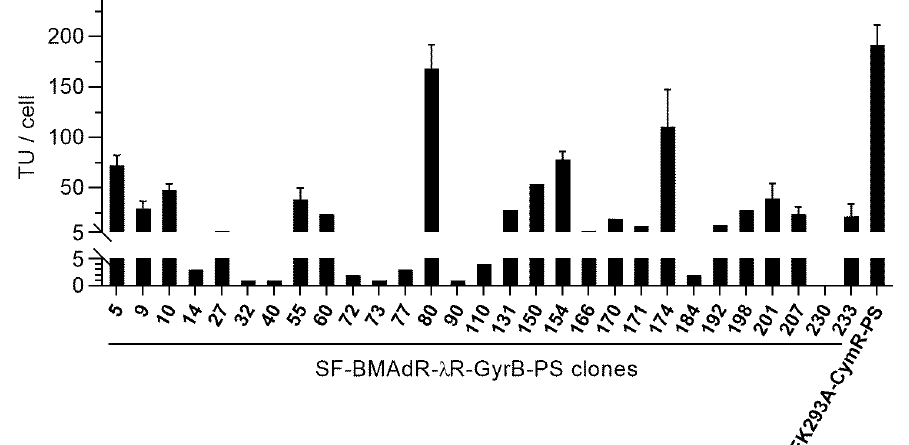
Figure 2. Comparative production of AdPS-/CU by SF-BMAdR- λ R-GyrB-PS clones. Cells were infected with AdPS-/CU using a MOI of 5 transduction unit(s) (TU)/cell in the presence of coumermycin (5 nM) for SF-BMAdR- λ R-GyrB-PS clones and cumate (50 µ g/mL) for HEK293A- CymR-PS pool. The specific productivities of infectious vector particles (TU/cell) were determined by flow cytometry and expressed as TU/cell. The samples with error bars were tested in triplicate ( n = 3) and are presented as mean ± SEM. The samples without error bars were analyzed only once ( n = 1). To ensure that the clones were monoclonal, the 10 best clones were subcloned in 96-well plates and the 54 resulting subclones were expanded and analyzed by a cell